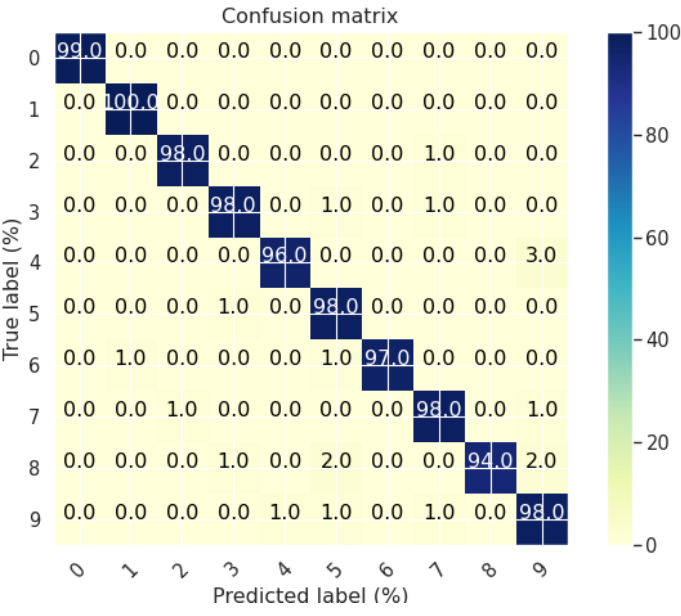
Figure 8. Confusion matrix of trained Client agent for Experiment 2.